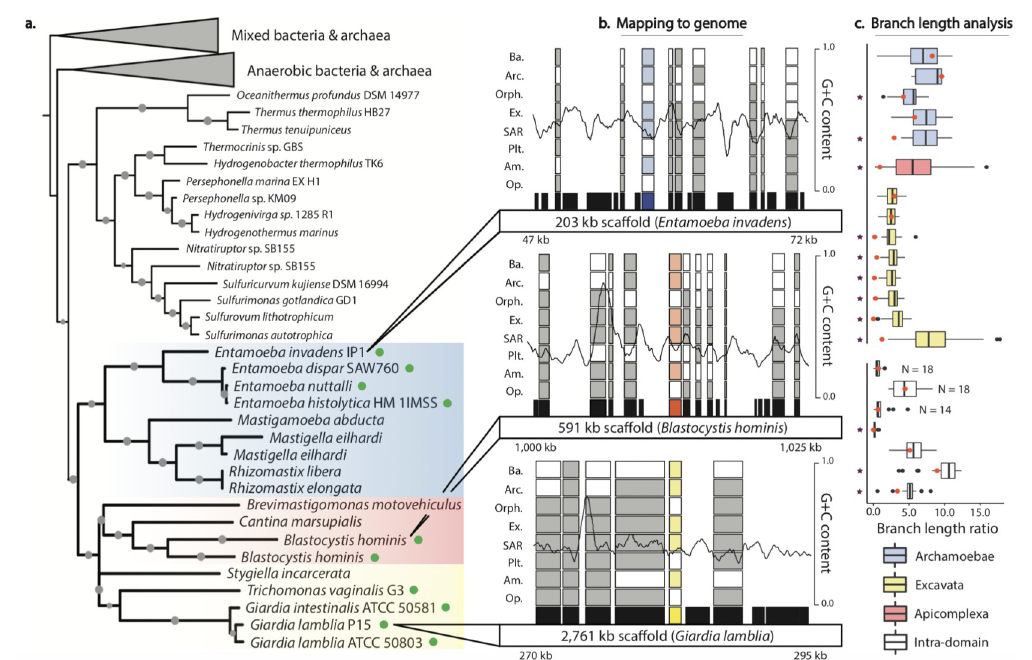
Fig 4. Using strict exclusive-presence criteria and extensive curation, we found evidence for both inter- and intradomain transfer involving anaerobic eukaryotes. (A) A glycyl-radical enzyme-activating enzyme (GRE-AE) is found exclusively in anaerobic eukaryotes (colored boxes) and prokaryotes. (B) Curation of genomic sequences (green dots in Fig 3A) kept only those that mapped to scaffolds longer than 10 kb and with robust nearby CDS as represented by the three scaffold sections: LTGs are shown in color and the presence/absence of nearby GFs in other eukaryotic and prokaryotic groups are shown by filled and empty squares, respectively (Ba: Bacteria; Arc: Archaea; Orphan: Eukaryotic orphan lineages; Ex: Excavata; Plt: Archaeplastida; Am: Amoebozoa; Op: Opisthokonta); sliding window GC content shows amelioration of these LTGs; CDSs (black boxes) with no presence/absence data are not in the PhyloToL database (e.g. lineage specific genes). (C) In most branch length comparisons, LTGs (red dots) fell below the first quartile of the branch-length ratios of the corresponding set of conserved genes (box plots) subsampled to mimic gene loss. This includes the distance between SAR and Excavata in the GRE-AE gene tree (A); the number of VTG trees is given for LTGs with fewer than 20 VTGs in their corresponding